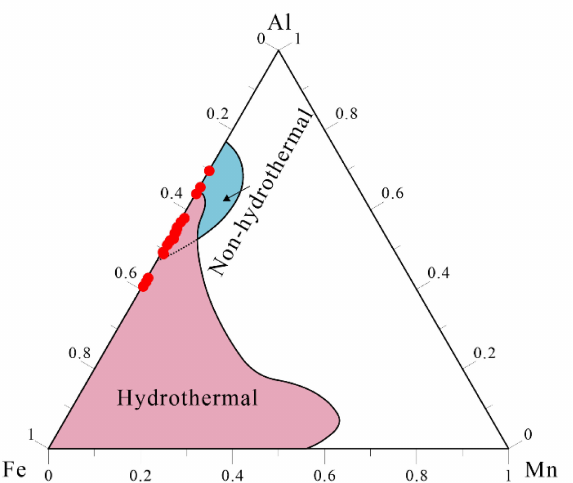
Figure 9. Al-Fe-Mn ternary plot of chert nodules in the Lucaogou Formation. Hydrothermal and non-hydrothermal chert fields are from Yamamoto et al. (1987)